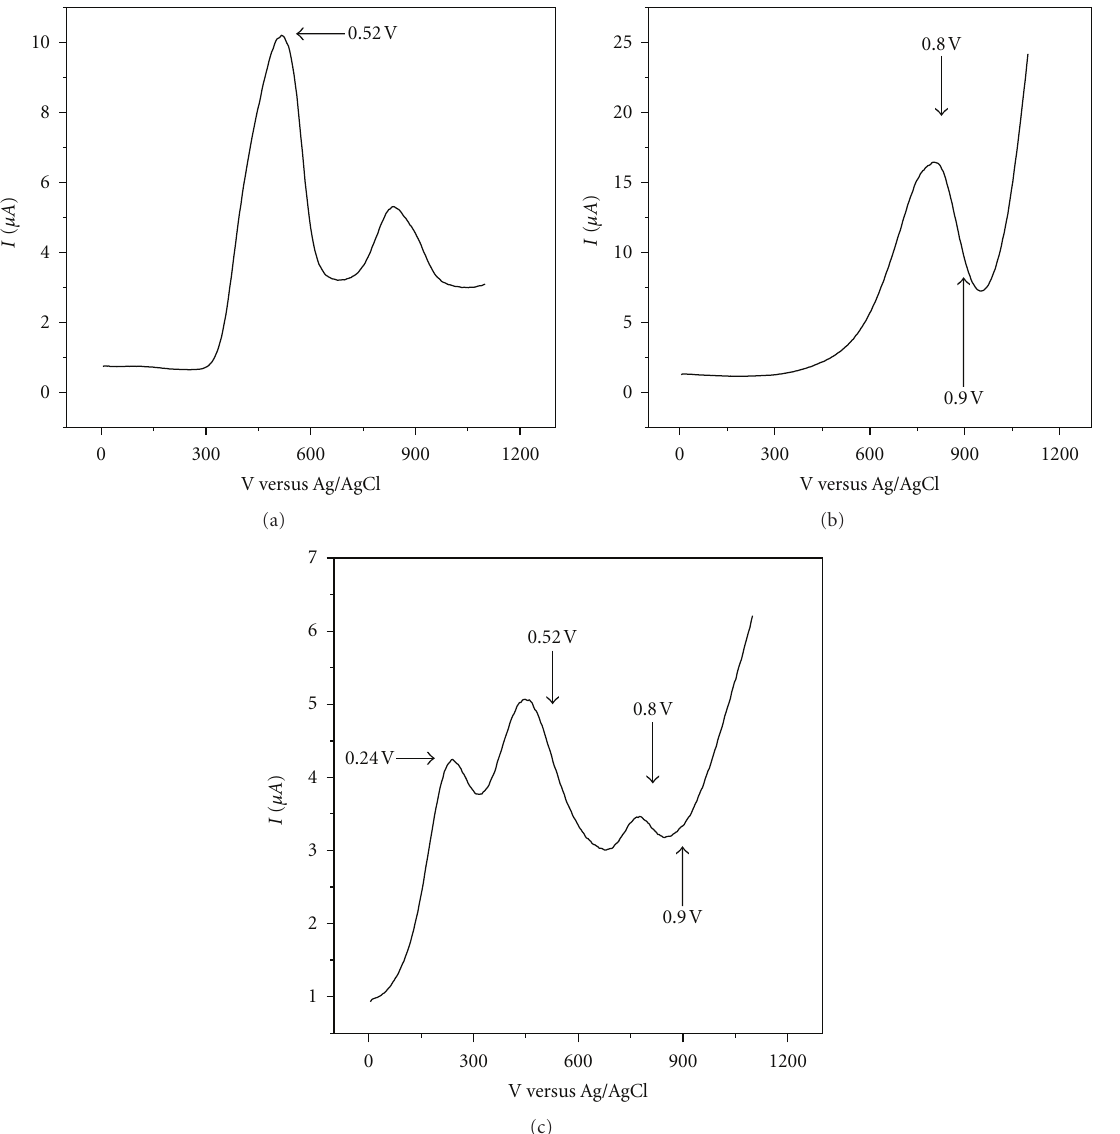
Figure 2: Cyclic voltammetry of (a) 10 mM SO 3 − 2 solution at pH 9.5. (b) 1 mM gallic acid solution and (c) a gallic acid-sodium sulfite mixture. Initial concentration 10 mM, pH 9.5. Scan rate 0.1 mVs − 1